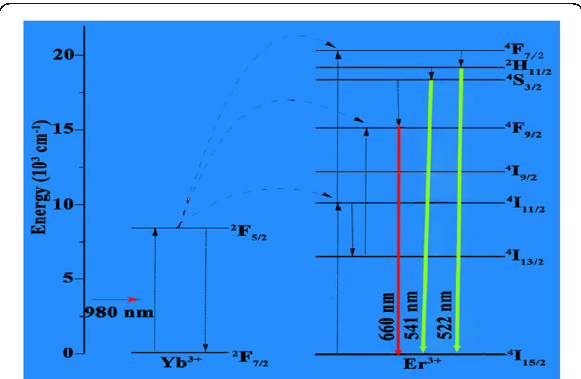
Fig. 8 Energy level diagram of LiYF 4 :Yb 3+ /Er